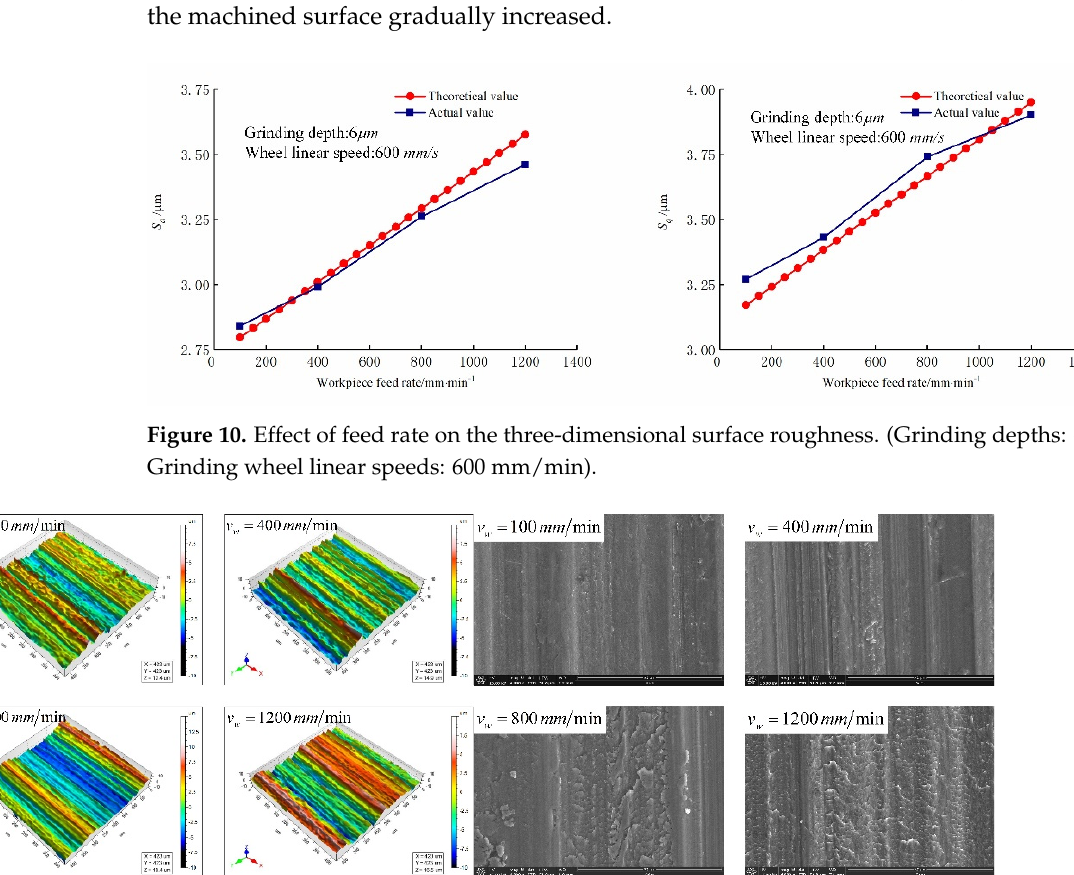
Figure 11. Comparison of three-dimensional surface microstructure under different feed rates. (Grinding depths: 6 µ m, Grinding wheel linear speeds: 600 mm/min). ( a ) White light interferometer observation results. ( b ) Scanning electron microscope observation results.